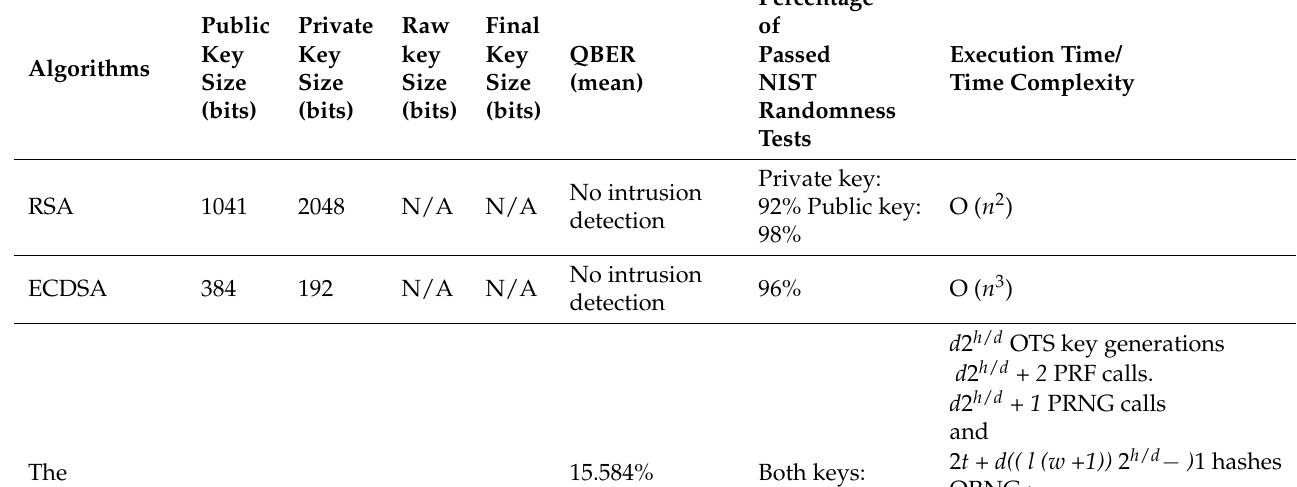
Table 9. Synthesis of comparative analysis of the proposed algorithm, RSA, ECDSA and SPHINCS-256.